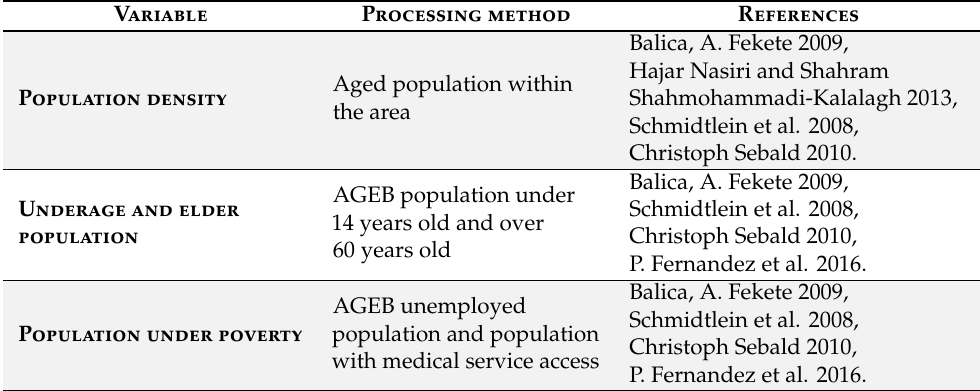
Table 1. Social vulnerability component indicators.